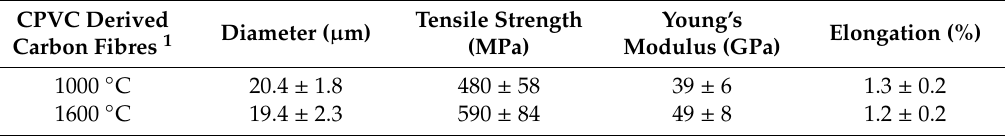
Table 2. The mechanical properties of the CPVC derived carbon fibres.